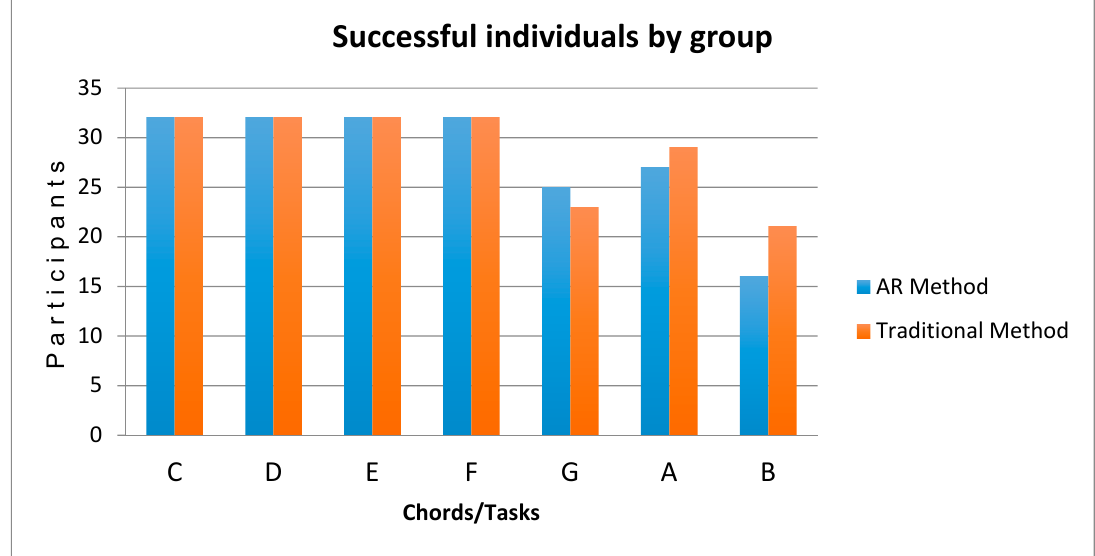
Figure 6. Comparison of AR methodology and traditional methodology: success rates.